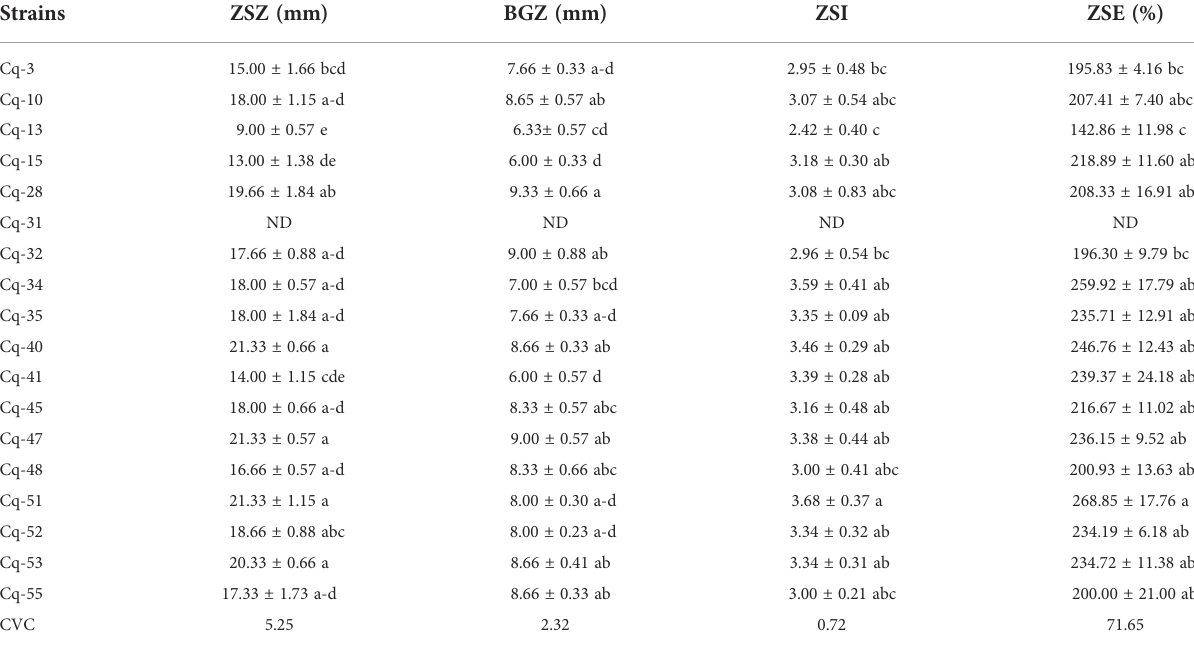
TABLE 2 Solubilization of zinc by phosphate solubilizing bacterial strains isolated from quinoa rhizosphere.